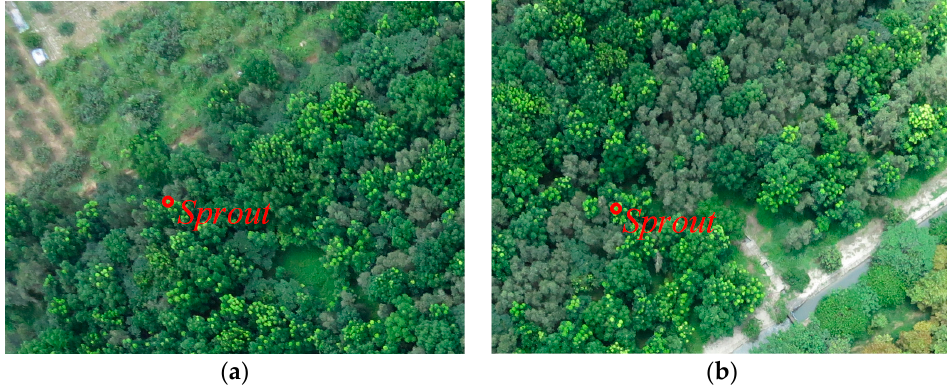
Figure 11. 1000 × 1300 actual images of a forest in central Taiwan: ( a ) actual image of Region 1; and, ( b ) actual image of Region 2.